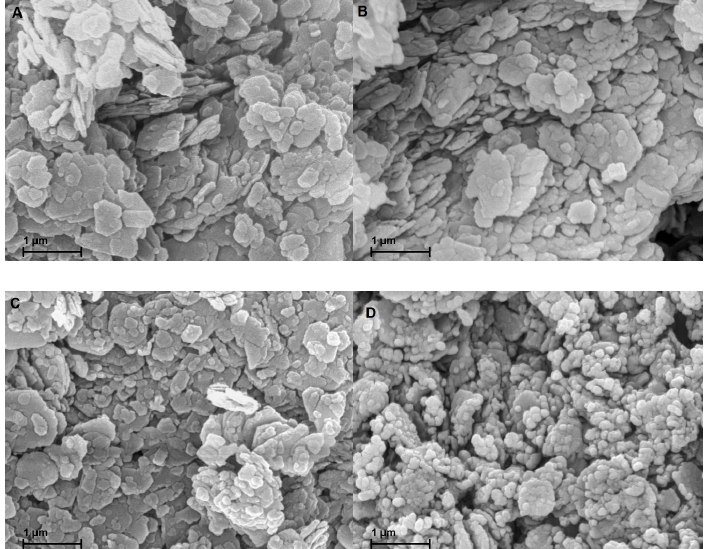
Figure 5. SEM images of the samples coated with gold of ( A) MK; ( B ) MK-H 2 O; ( C ) MK-KOH; ( D )